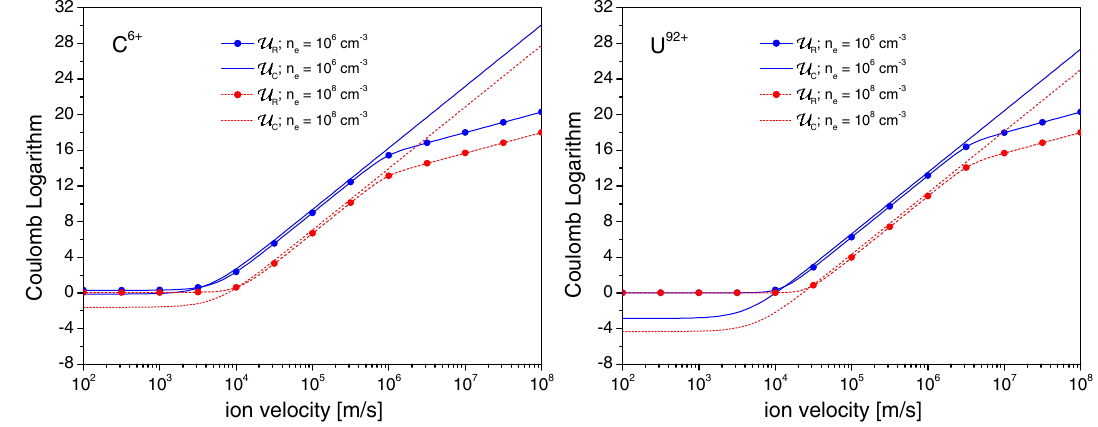
FIG. 9. Regularized (cid:4) ð ß Þ (the lines with symbols) given by Eq. (25) and standard U C (the lines without symbols) Coulomb logarithms (in m = s ). The Coulomb logarithms are calculated for for C 6 þ (left panel) and U 92 þ (right panel) fully stripped ions as a function of v i k ¼ 0 , B ¼ 0 : 1 T and for T ¼ 0 : 11 eV , T ¼ 0 : 1 meV , n ¼ 10 6 cm (cid:1) 3 (solid lines), and n ¼ 10 8 cm (cid:1) 3 (dotted (cid:2) 0 ¼ 10 (cid:1) 9 m , v ? k i ? e e